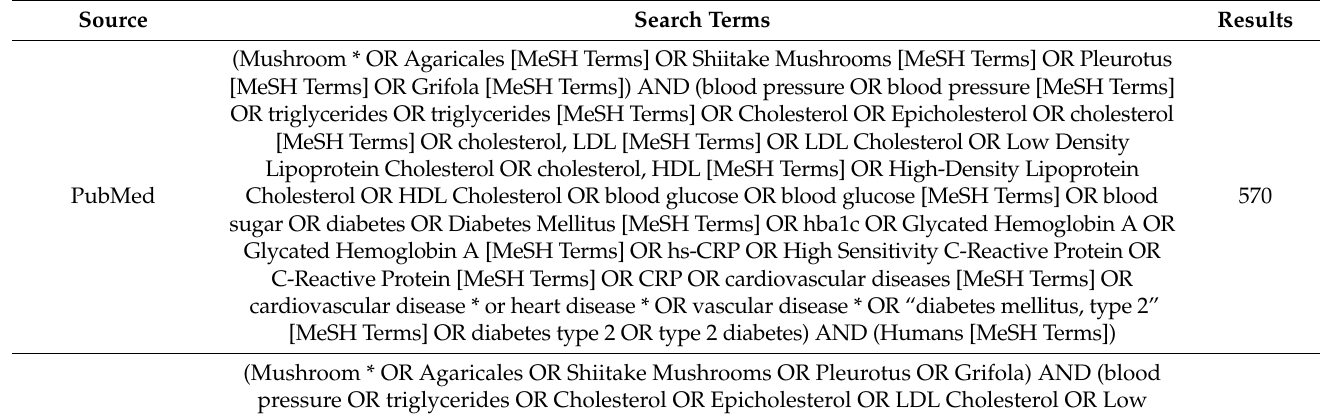
Table 2. Search terms and results for a systematically searched literature